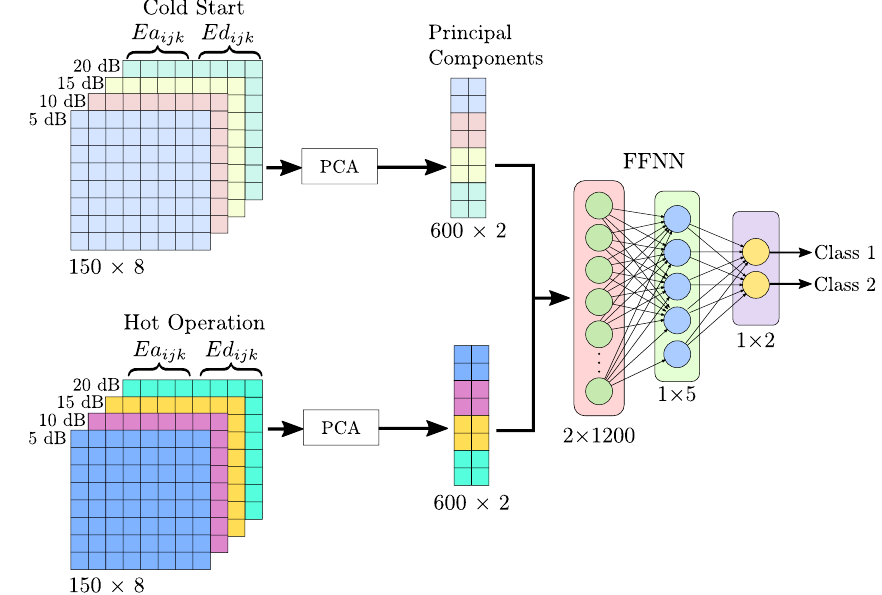
Figure 6. Dataset dimensional reduction and rearrangement for FFNN